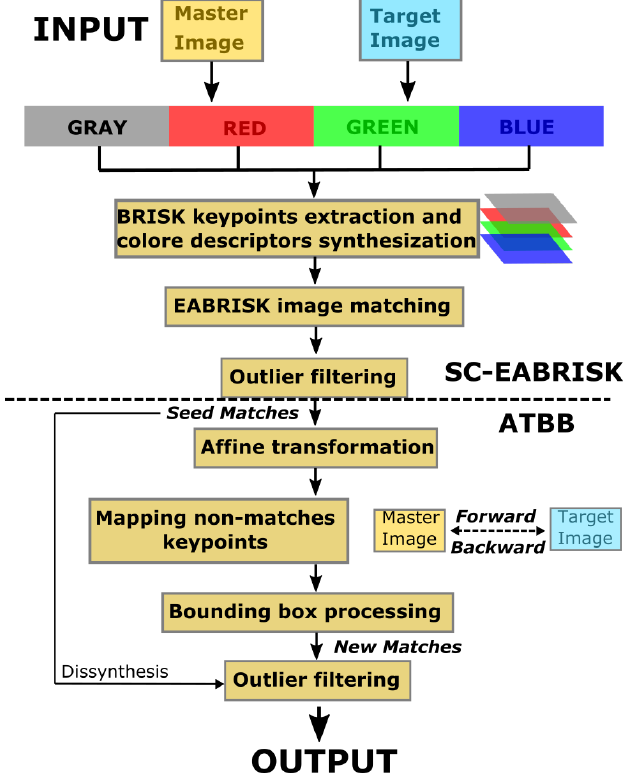
Figure 1. The proposed two-step workflow for image